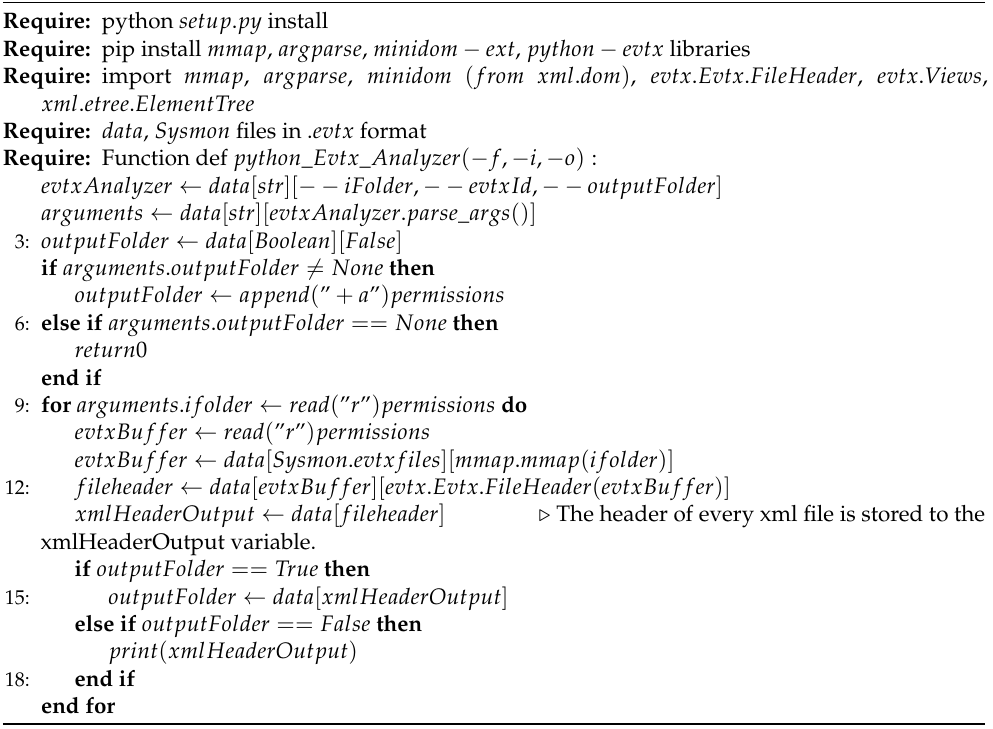
Algorithm 1 PeX’s arguments and folders initialization algorithm